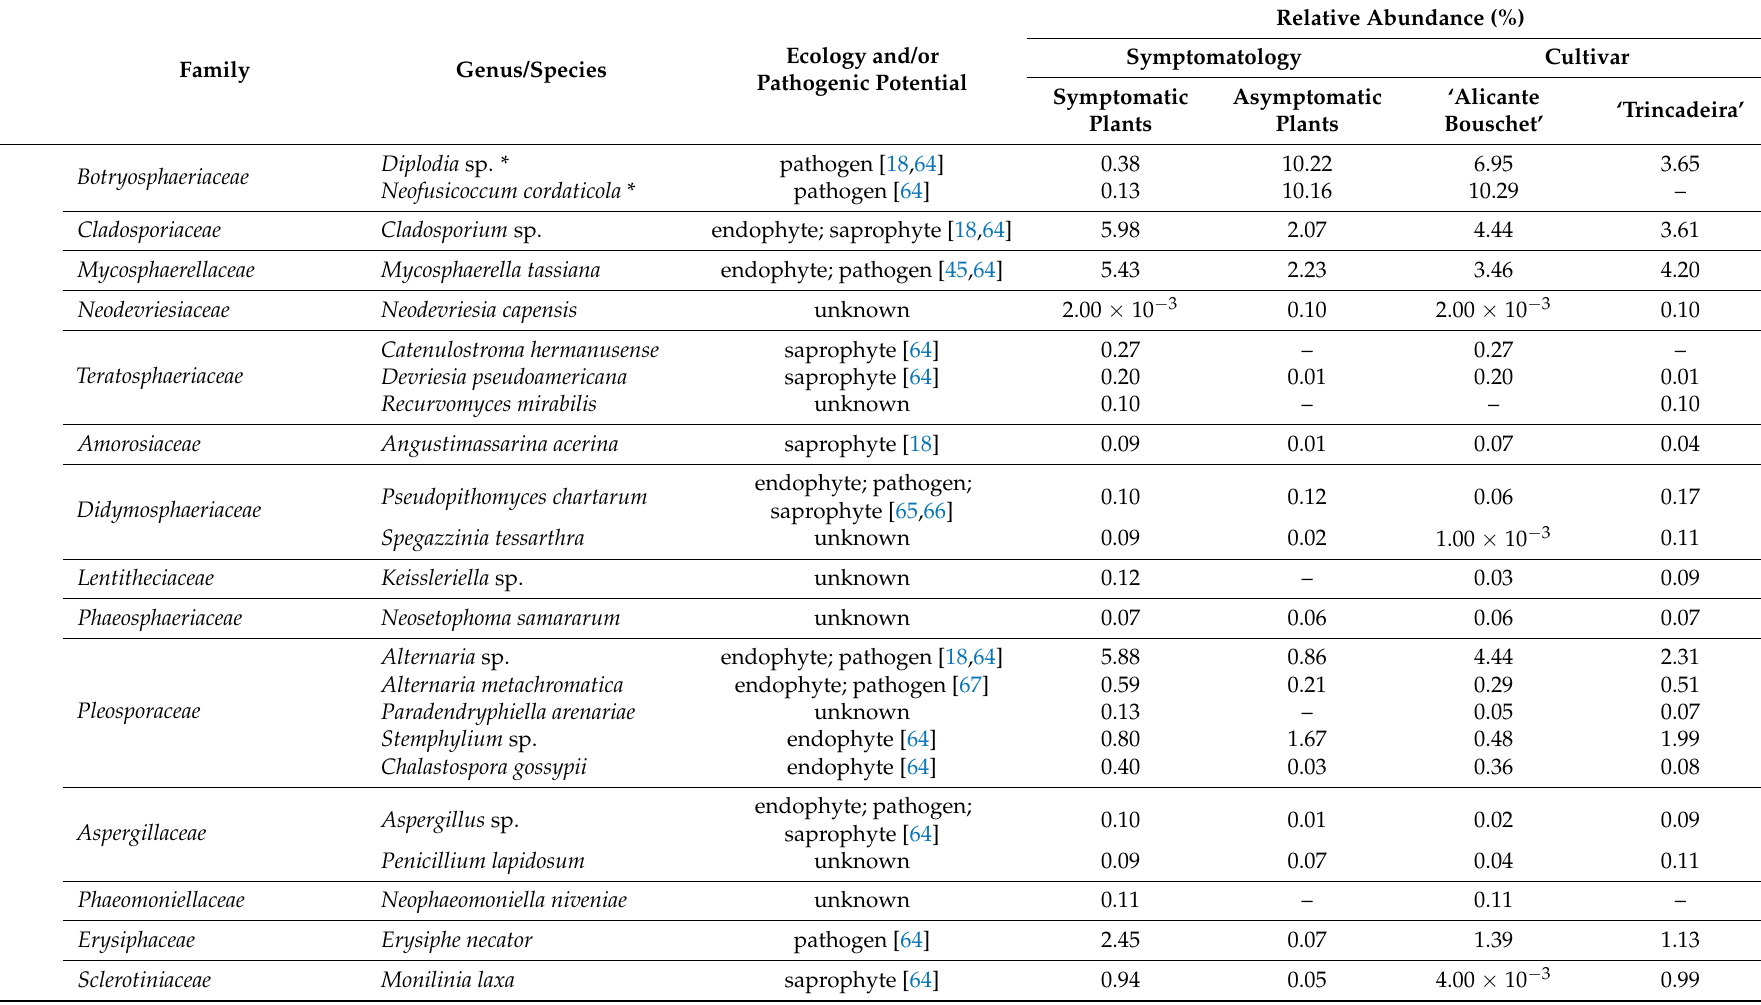
Table 2. Taxonomic classification of the most abundant taxa (with relative abundance ≥ 0.10%), identified to genus or species level, their ecology and/or pathogenic potential, and relative abundance in GTDs symptomatic and asymptomatic plants and in the studied grapevine cultivars (‘Alicante Bouschet’ and